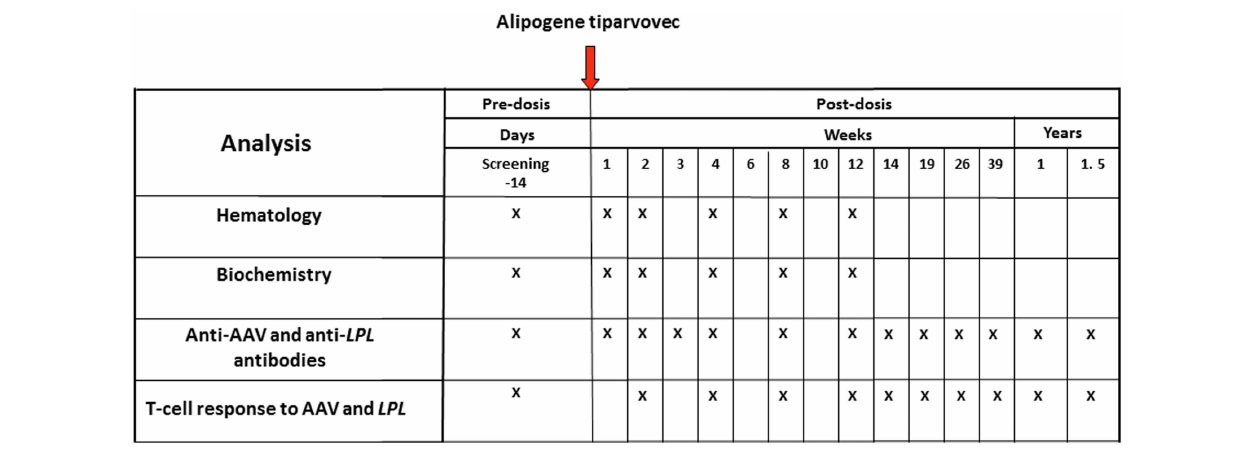
FIGURE 2 | Clinical analyses schedule of the studies with alipogene tiparvovec until 1.5years after drug delivery